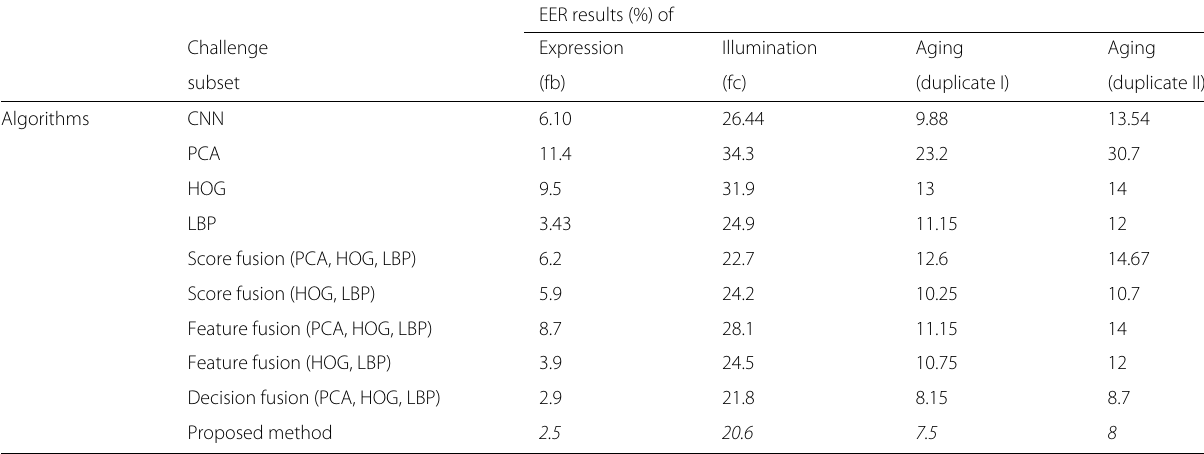
Table 10 EER results for non-twins using standard FERET subsets under expression, illumination and age